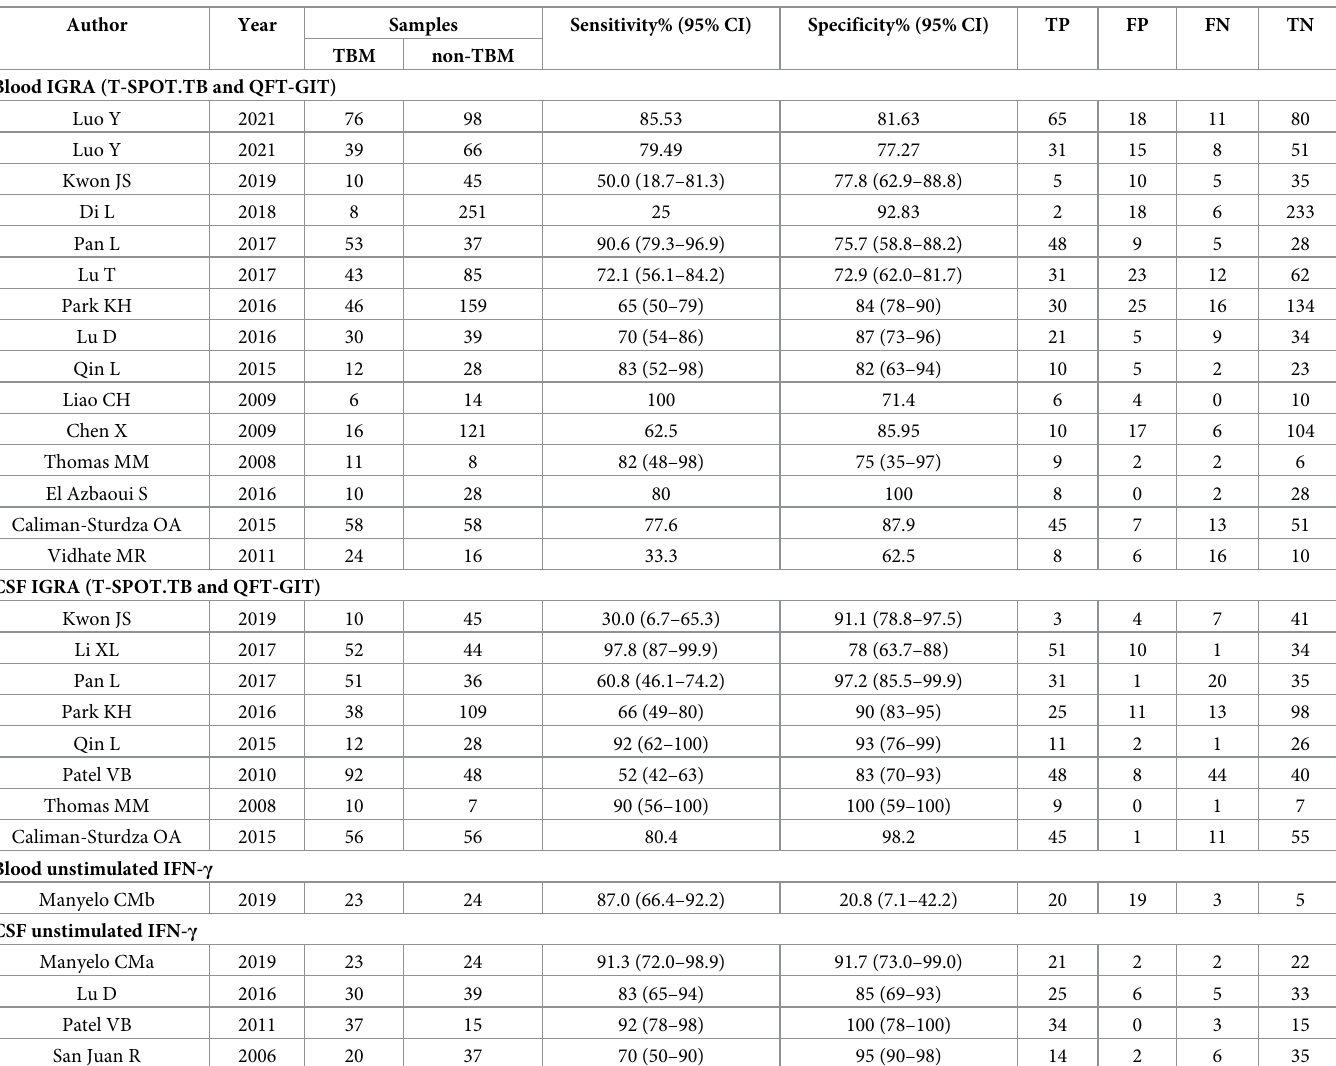
Table 2. Diagnostic performance of IFN- γ in the individual